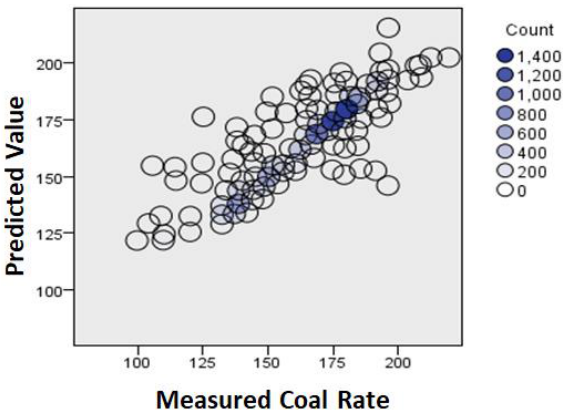
Figure 16. Relationship between the measured and predicted injection coal rate in the multiple linear regression model.